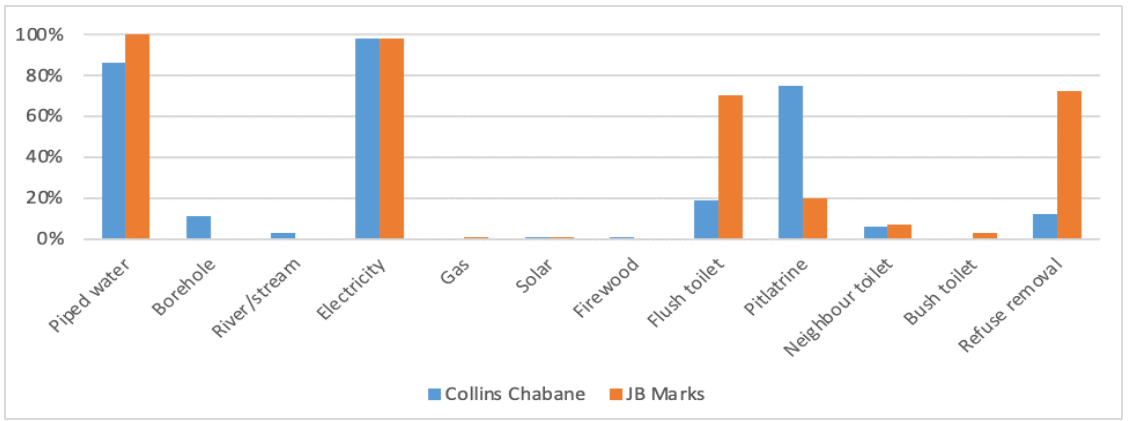
Figure 2: Households’ access to water, energy, sanitation and refuse